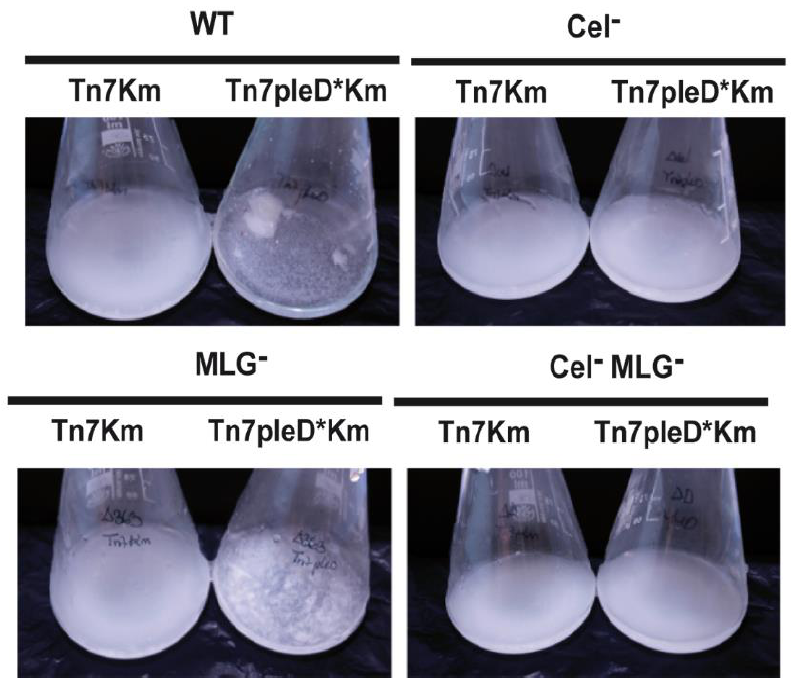
Figure 3. Role of the β -glucans Cellulose and MLG in the flocculation of R. etli CFN42 . Single mutants in celAB cellulose genes (Cel − ), in bgsA (MLG − ), the double mutant (Cel − MLG − ) and their respective parental strains (WT) with or without pleD* were grown in minimal medium with shaking. Flasks were photographed after 24 h of growth at 28 °C to observe the flocs.